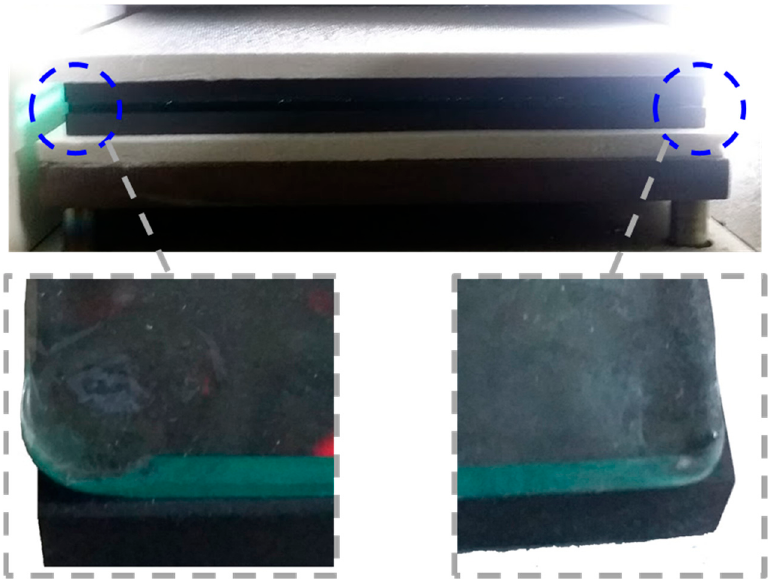
Figure 11. Experimental results obtained with a susceptor, a target temperature of 500 °C, and a heating rate of 8 °C/min. The experimental system ( left ), deformation at the glass corners ( middle and right ).